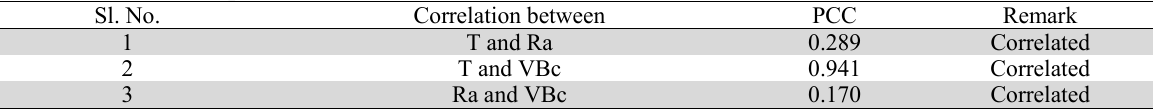
PCC between the responses